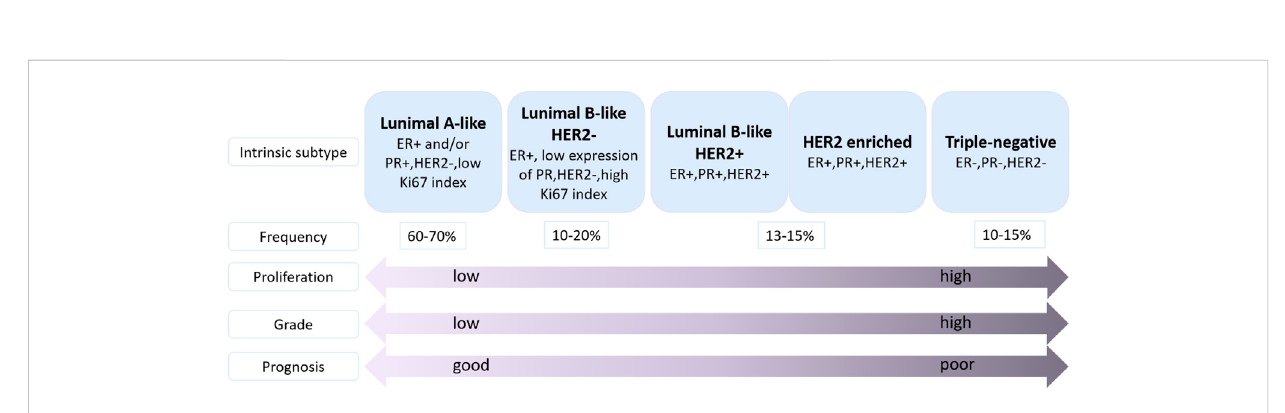
FIGURE 2 Classi fi cation of molecular subtypes of breast cancer (Harbeck et al., 2019). ER: estrogen receptor, PR, progesterone receptor; HER2, human epidermal growth factor receptor 2; Ki67, proliferation marker.